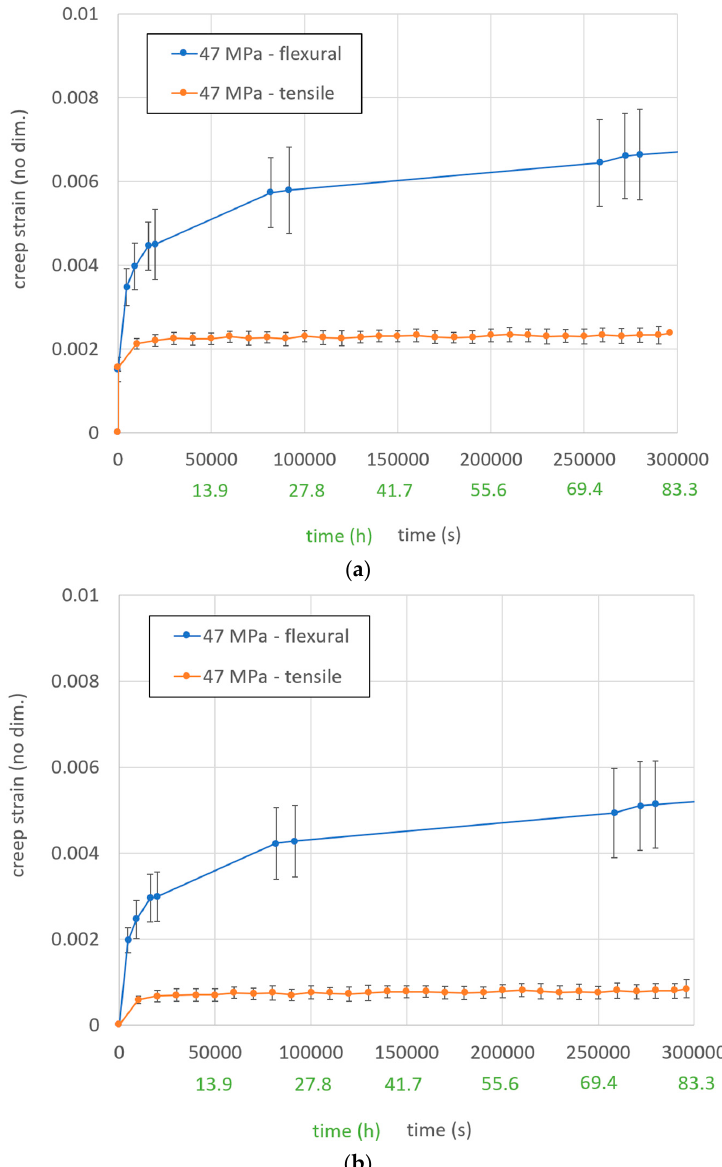
Figure 9. Comparison of different stress states at the same stress level for: ( a ) total strain over time; ( b ) creep strain over time.